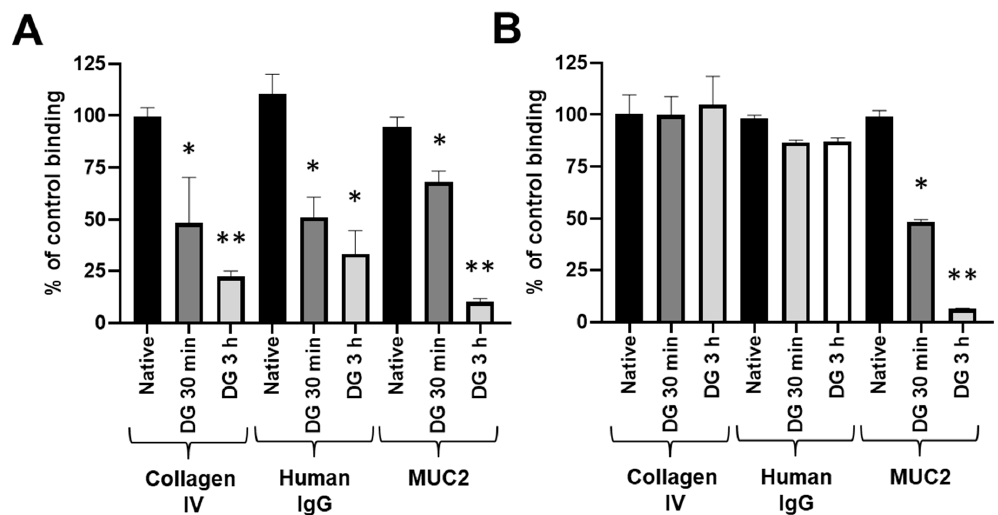
Figure 5. The interaction of GST-RadA 35-252 with MUC2 depends on a glucidic motif. The binding of WGA ( A ) or GST- RadA 35-252 ( B ) to native and deglycosylated (DG) collagen IV, human IgG or mucin type II (MUC2) (coated at 4 pmol per wells (40 nM)) was measured as explained in Materials and Methods. Results are expressed as means ± S.D. with *: p < 0.05; **: p < 0.01 ( n = 3).